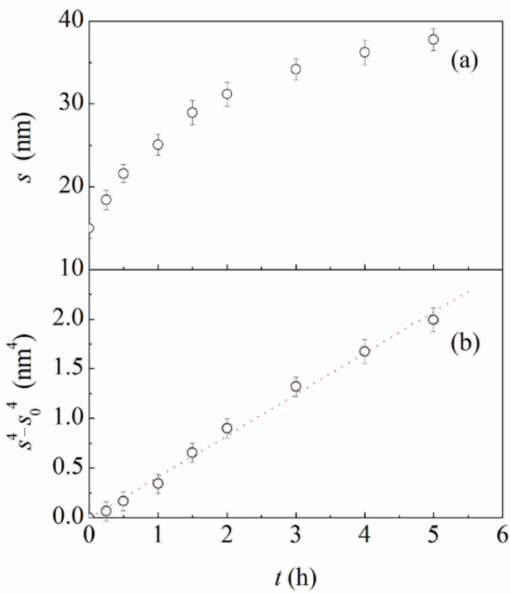
Figure 2. The average ligament thickness, s, and ( b ) the quantity, s 4 − s 4 time, t. Best-fitted line is also